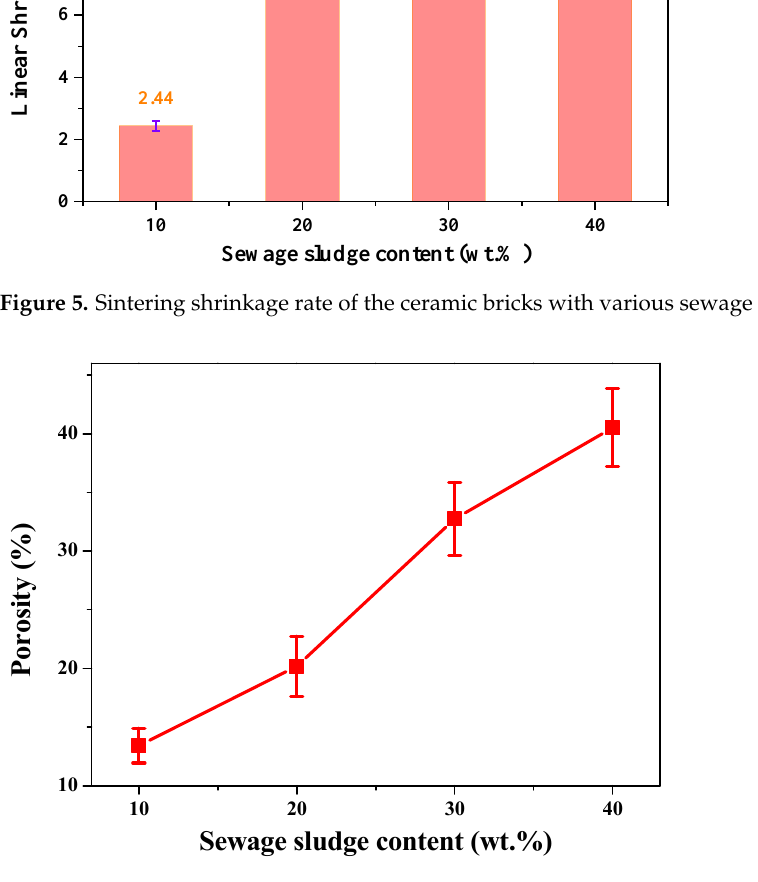
Figure 6. Porosity of the ceramic bricks with various sewage sludge contents.